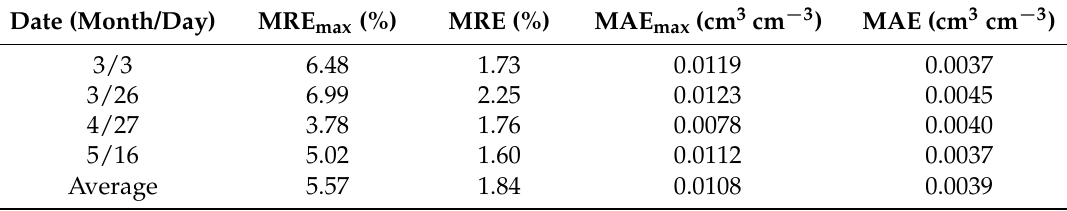
Table 4. Error between simulated and observed values for soil water content. MAE: mean